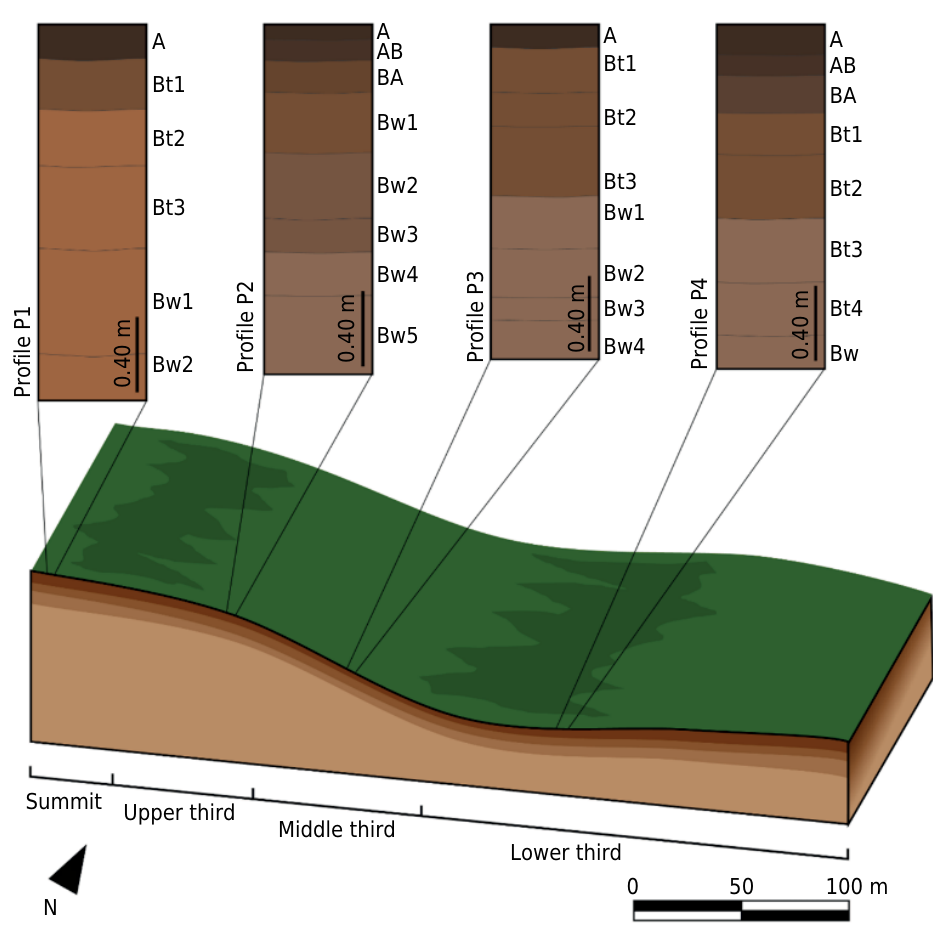
Figure 2. Schematic representation of the toposequence and soil profiles sampled in Pinheiral, Rio de Janeiro State, Southeastern